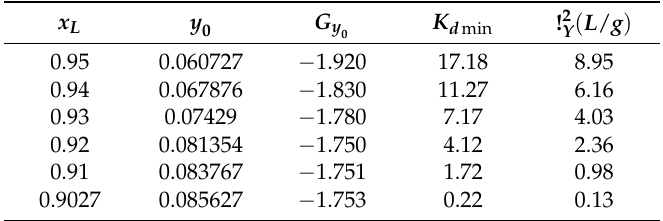
Table 2. The dimensionless minimum stiffness and angular frequency.